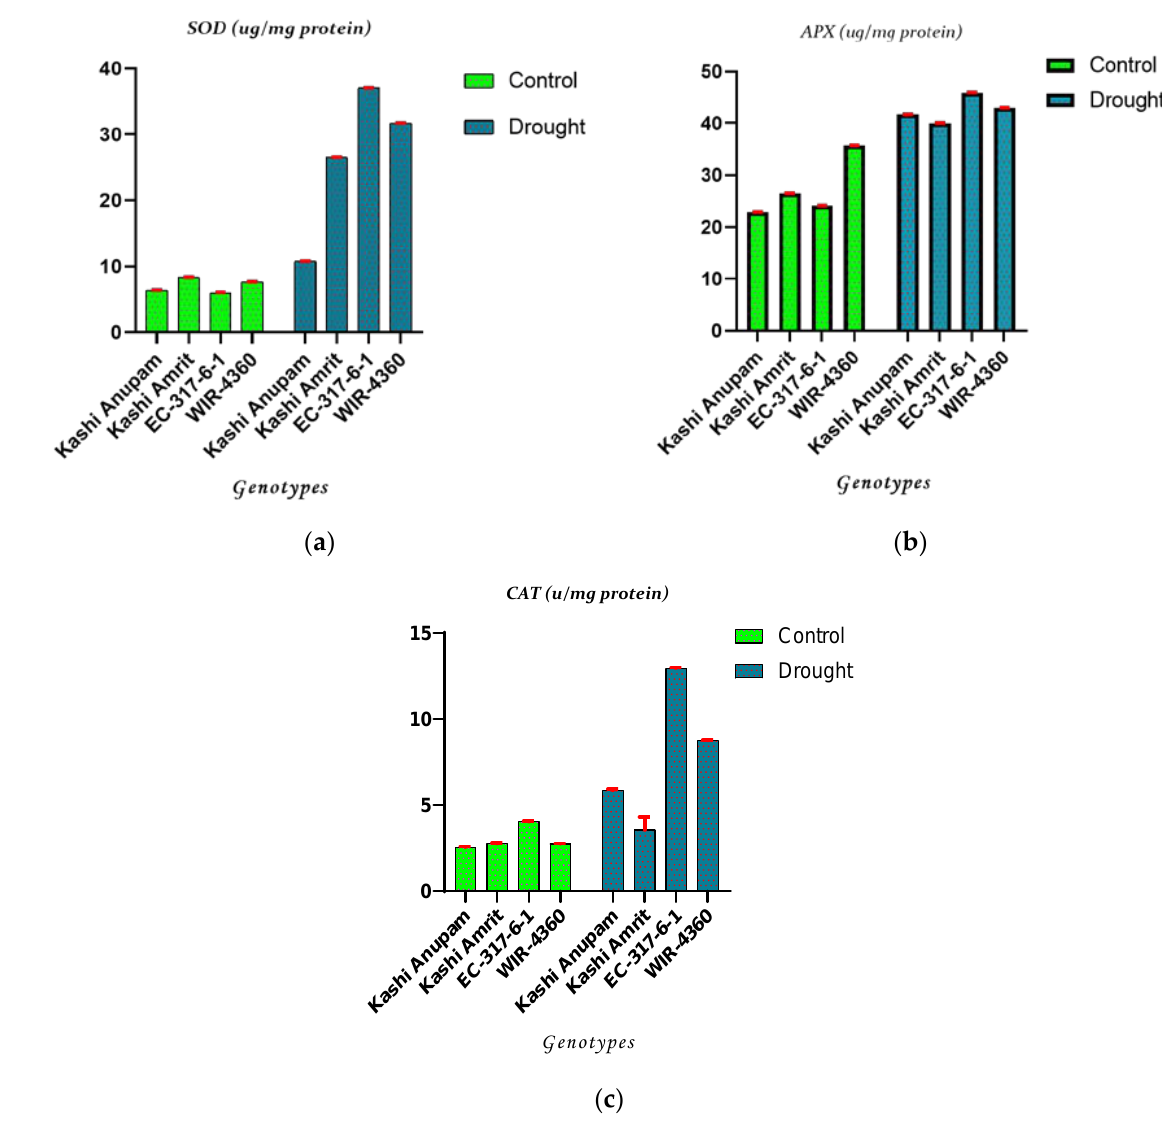
Figure 1. Antioxidant enzyme activities (μmol/g) of SOD ( a ), APX ( b ), and CAT ( c ) in tomato genotypes under irrigated and drought conditions. Values are the means of three replicates with standard deviations. Different bar letters show significant differences among treatments separately.